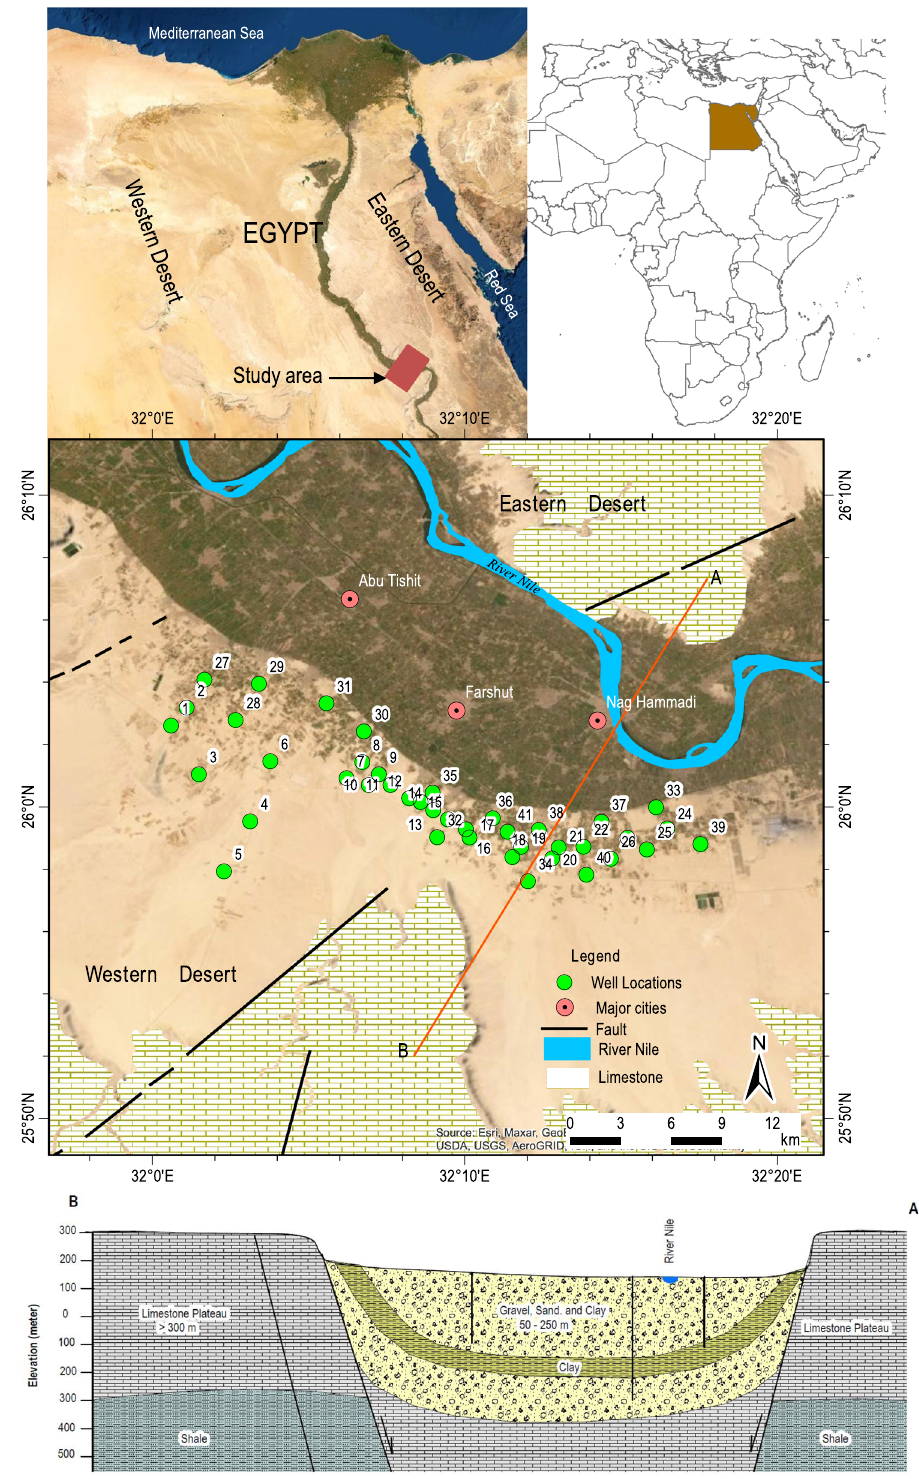
Fig. 1 Overview figure of the study area showing: world location of Egypt, physical map of Egypt shows the location of the study area, and detailed map of the study area shows the samples and the cross section ( A – B ) locations. ( Source: Free ArcGIS base map